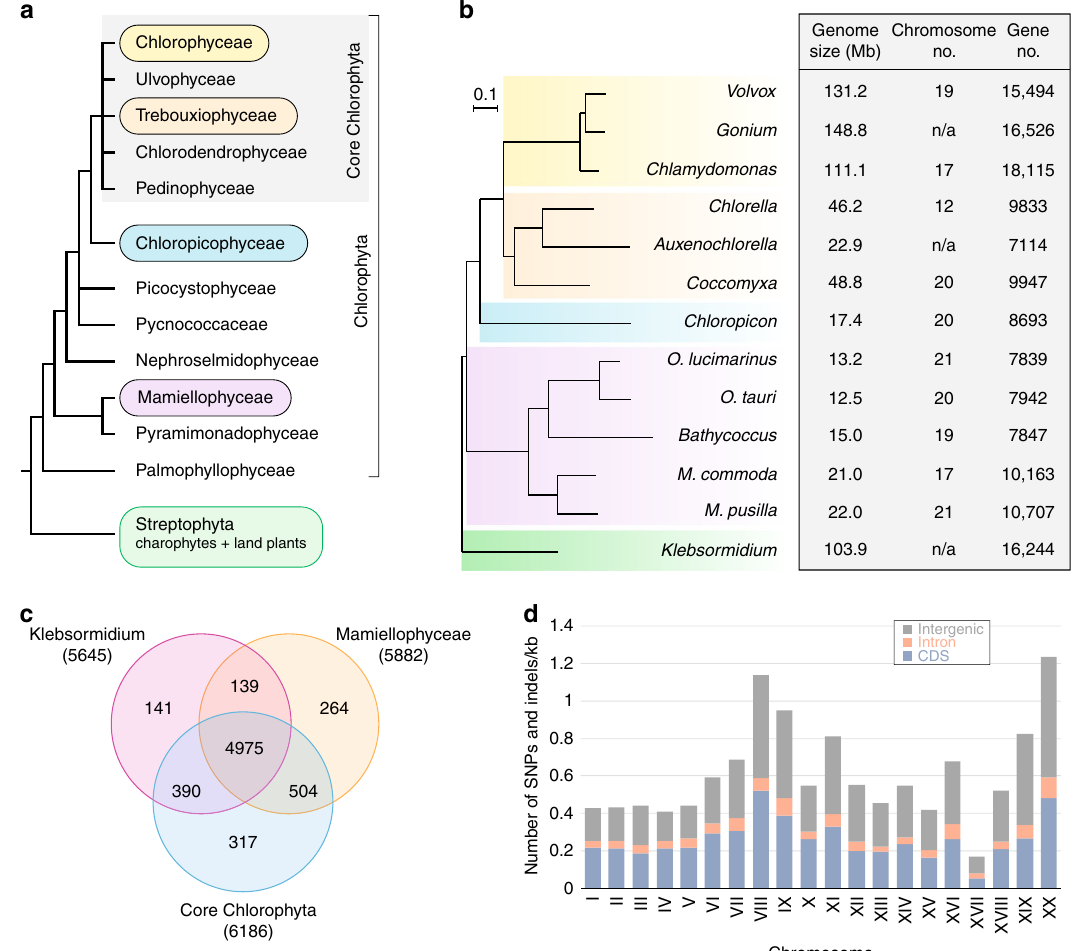
Fig. 1 Phylogenetic position and genome features of Chloropicon relative to the 12 green algae selected for comparative analyses. a Schematic diagram depicting the main lineages of the Chloroplastida. The algae of our study group belong to the highlighted lineages. b Nuclear phylogenomic tree inferred from 792 concatenated proteins encoded by single-copy genes and comparison of genome sizes, numbers of chromosomes/DNA assemblies, and sizes of protein-coding gene repertoires. c Venn diagram showing the numbers of protein-coding genes that Chloropicon shares with the Mamiellophyceae, core chlorophytes and Klebsormidium . d Density of SNPs and small indels in coding (blue bars) and non-coding (intron, orange bars; intergenic sequences, gray bars) regions of individual Chloropicon chromosomes. The source data of d are provided as a Source Data fi